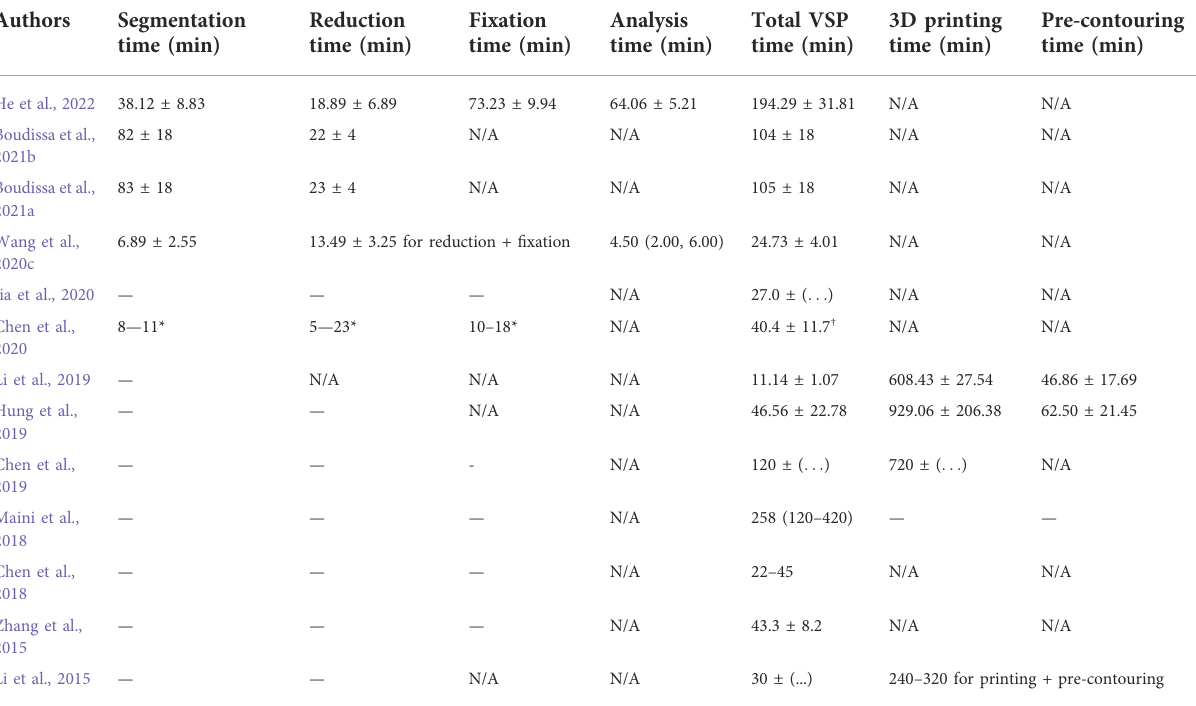
*Values read from graph. † Recalculated from three fracture